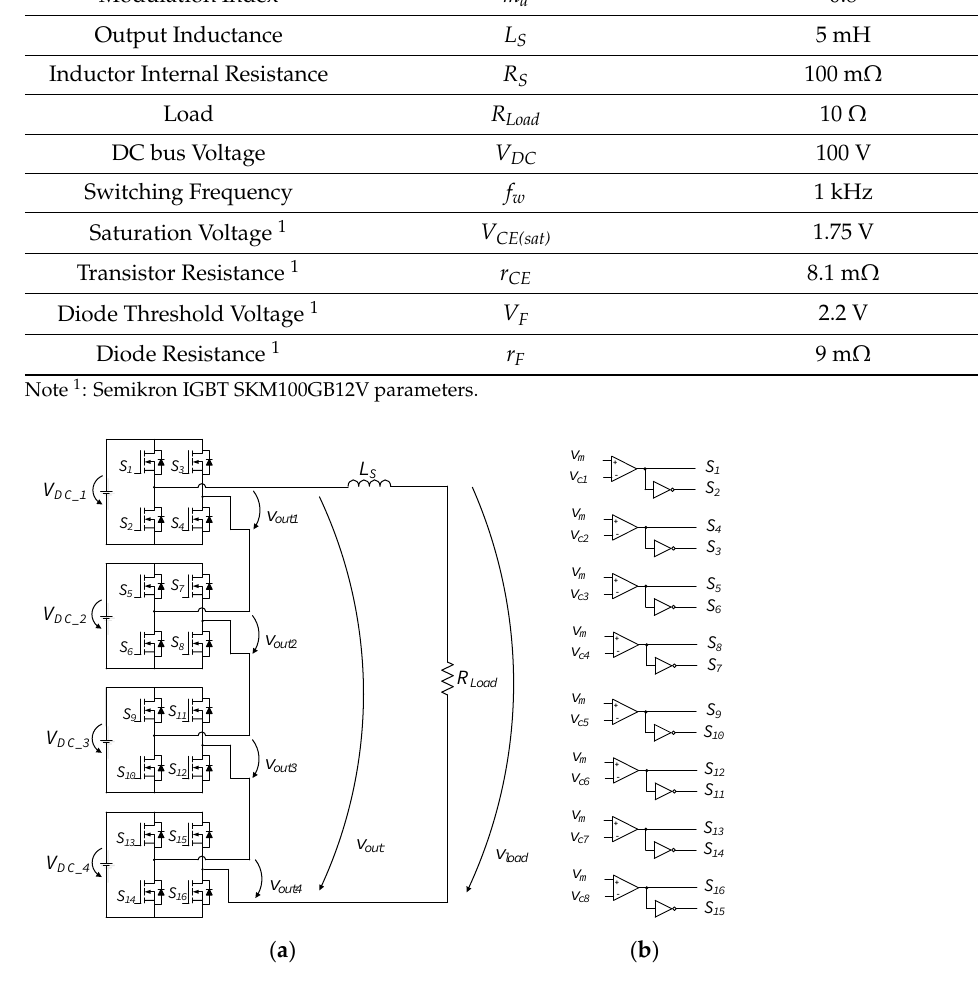
Figure 12. Electrical schematic of the ( a ) cascaded full-bridge and ( b ) PWM control circuit. With this configuration of four submodules composed of full-bridges topology, it is possible to obtain 256 redundant states, with each voltage level having a limited number of states, as shown in Table 5. By analyzing Table 5, it is possible to verify that there is only one state to generate 4 V DC at the v out , when the four submodules are generating V DC . On the other hand, to generate 3 V DC , there are right states: when three of the submodules are generating V DC and a single submodule is generating 0. As there are two possibilities of generating 0 and four submodules, it is possible to obtain the right states. Continuing with the analysis, to generate 2 V DC , there are twenty-eight redundant states that are es- sentially divided into two conditions: (i) when three submodules generate 3 V DC and an- other submodule generates − V DC and (ii) when two submodules generate 2 V DC and the others are generating 0. Within these conditions, there are four combinations to generate 3 V DC − V DC and twenty-four combinations to generate 2 V DC + 0 + 0. In turn, to generate V DC , there are fifty-six states, which can be divided into two conditions: (i) two submod- ules to generate 2 V DC , one generating − V DC and the fourth submodule generating 0 and (ii) one submodule generating V DC and the remaining three submodules generating 0. Re- garding the first condition, there are twelve possible combinations to generate 2 V DC − V DC + 0. Once there are two conditions to generate 0, the number of states is doubled, thus accounting for twenty-four states for 2 V DC − V DC + 0. In turn, for the V DC + 0 + 0 + 0 condi- tion, there are thirty-two states. Finally, for the 0 state, it is possible to count fifty-four states, which can be divided into three conditions: (i) when two submodules generate 2 V DC and the remaining two submodules are generating − 2 V DC ; (ii) when a submodule is generating V DC , one submodule is generating − V DC , and the remaining two submodules are generating 0; and (iii) all submodules are generating 0. For the first condition, there are six possibilities for generating 2 V DC − 2 V DC . Regarding the second condition, there are twelve states to generate V DC − V DC + 0 + 0. As there are two possibilities of 0 V DC , the number of states is replicated to twenty-four. Regarding the last group, it is possible to count twenty-four states to generate the condition 0 + 0 + 0 + 0. For negative values, the number of states is equal to the number of positive values, changing the condition to generate − V DC . Table 5. Redundant states for the cascaded four submodules full-bridge. Output Level